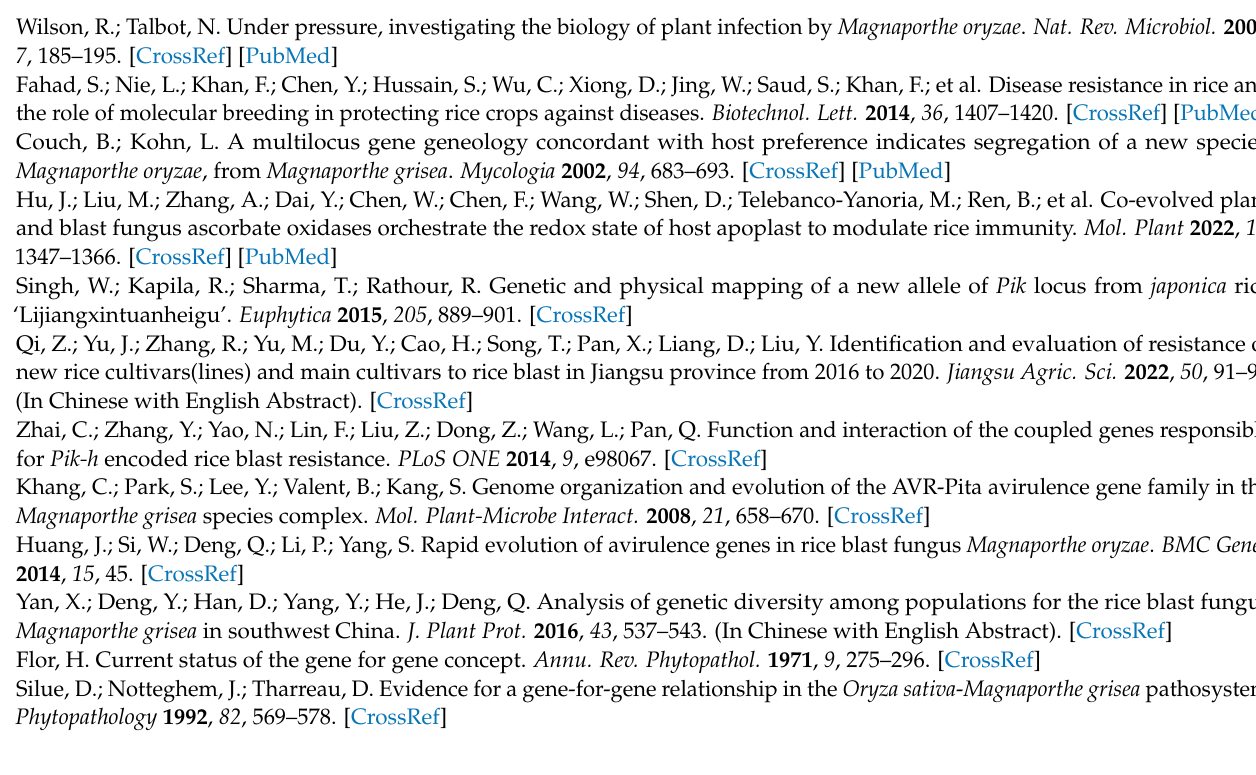
Table S4: The distribution rate of rice varieties containing R genes in three regions of Jiangsu province; Table S5: The ANOVA analysis of seven models; Table S6: The resistant evaluation of rice varieties in seven gene